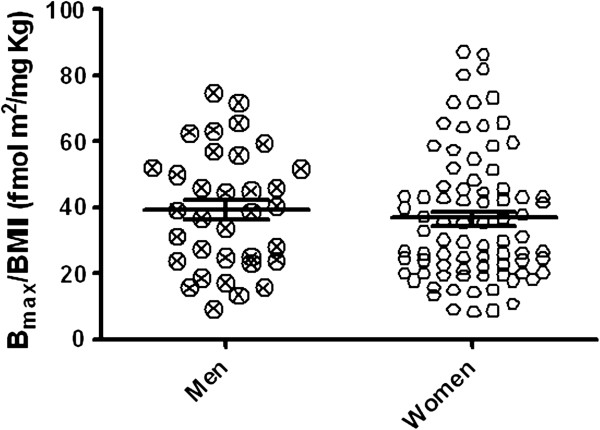
Comparison of [3H]-paroxetine Bmax/BMI ratios (SERT density/BMI, fmol m2/mg Kg), in males and females. Scattergram plots of [3H]-paroxetine Bmax/BMI ratios obtained in men and women. Each scattergram plot also shows the mean ± SEM.